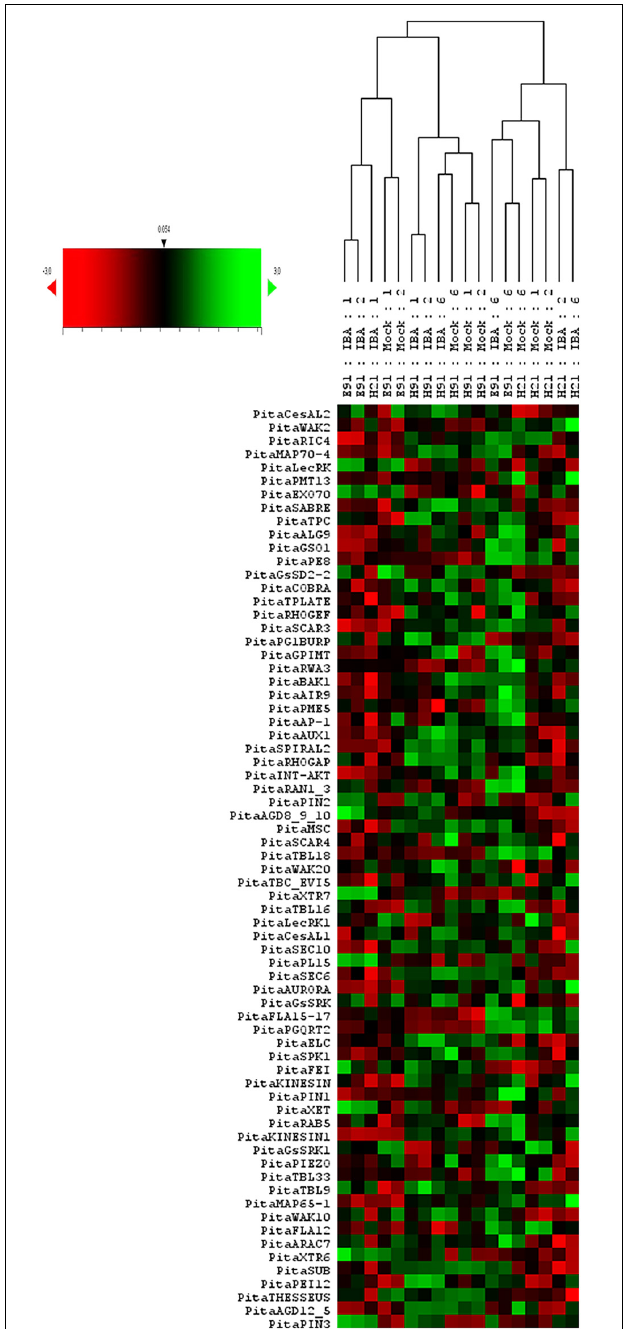
FIGURE 1 | Expression profile of genes involved in the cell wall–plasma membrane–cytoskeleton continuum in rooting-competent hypocotyl cuttings from 21-day-old seedlings (H21) and in both non-competent hypocotyl (H91) and epicotyl (E91) cuttings from 91-day-old-seedlings during adventitious root formation. RNA was extracted from the base of hypocotyl (H) and epicotyl (E) cuttings treated with 10 µ M indole-3-butyric-acid at the indicated times (days). Hypocotyl and epicotyl cuttings maintained in water were used as controls (mock). An agglomerative cluster analysis was performed based on the Pearson’s distance between gene expression levels and plotted as a heat map with a dendrogram of sample